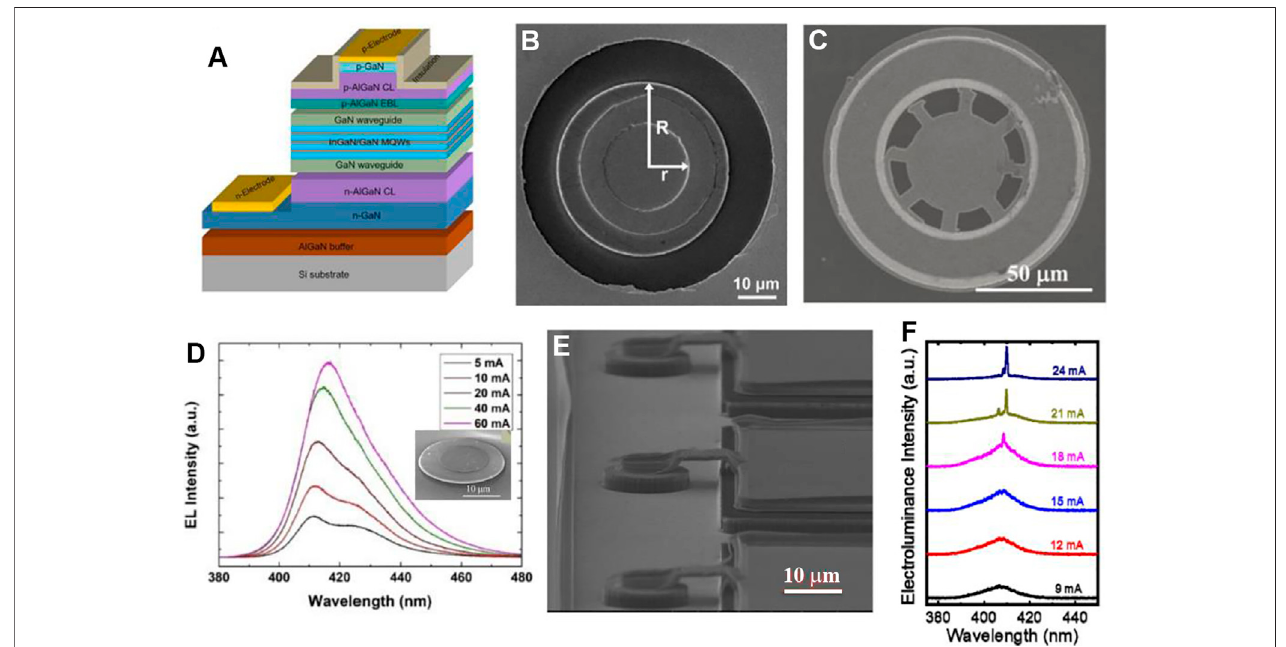
FIGURE 8 | (A) Typical layer structure of the GaN-based laser diode (LD) on an Si substrate. (B,E) SEM images of the GaN microdisk for electrically driven lasing (Wang et al., 2020; Feng et al., 2021) and (C) GaN microwheel for LED (Zhu et al., 2020b). EL spectra of the (D) GaN microdisk (Mei et al., 2021) and (F) microdisk laser (Wang et al., 2020). Reprinted with permission © Elsevier Publishing (Feng et al., 2021), © IOP Publishing (Zhu et al.,